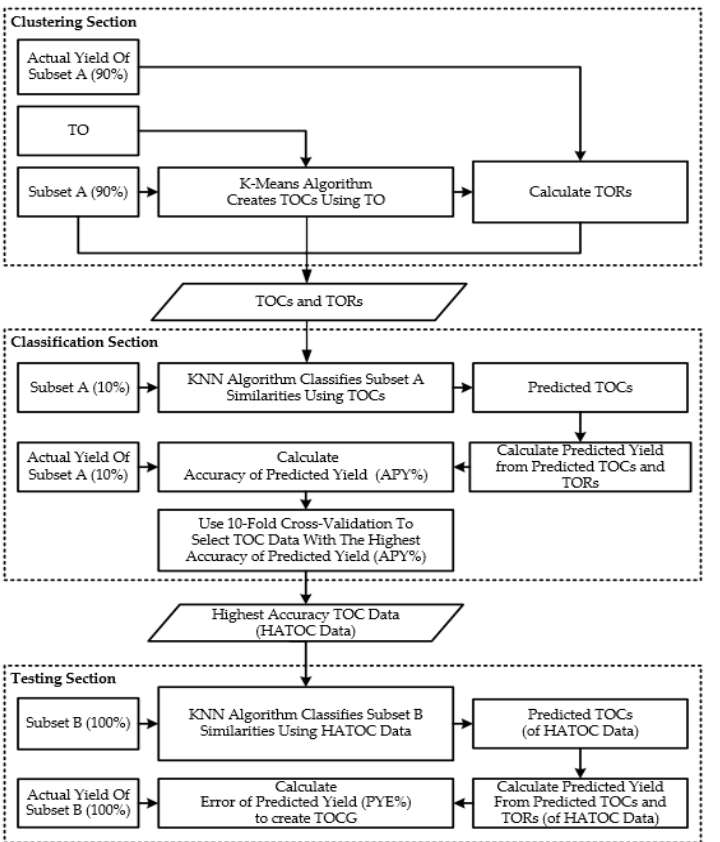
Figure 8. Conceptual framework of the Target Output Similarity Relationship Method (TO = Target Output, TOC = TO Cluster, TOR = TO